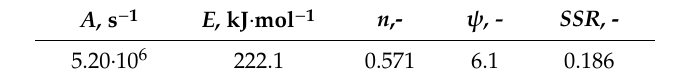
Table 4. Optimal values of kinetic parameters in the RPM model for CO 2 gasification of RPC char.